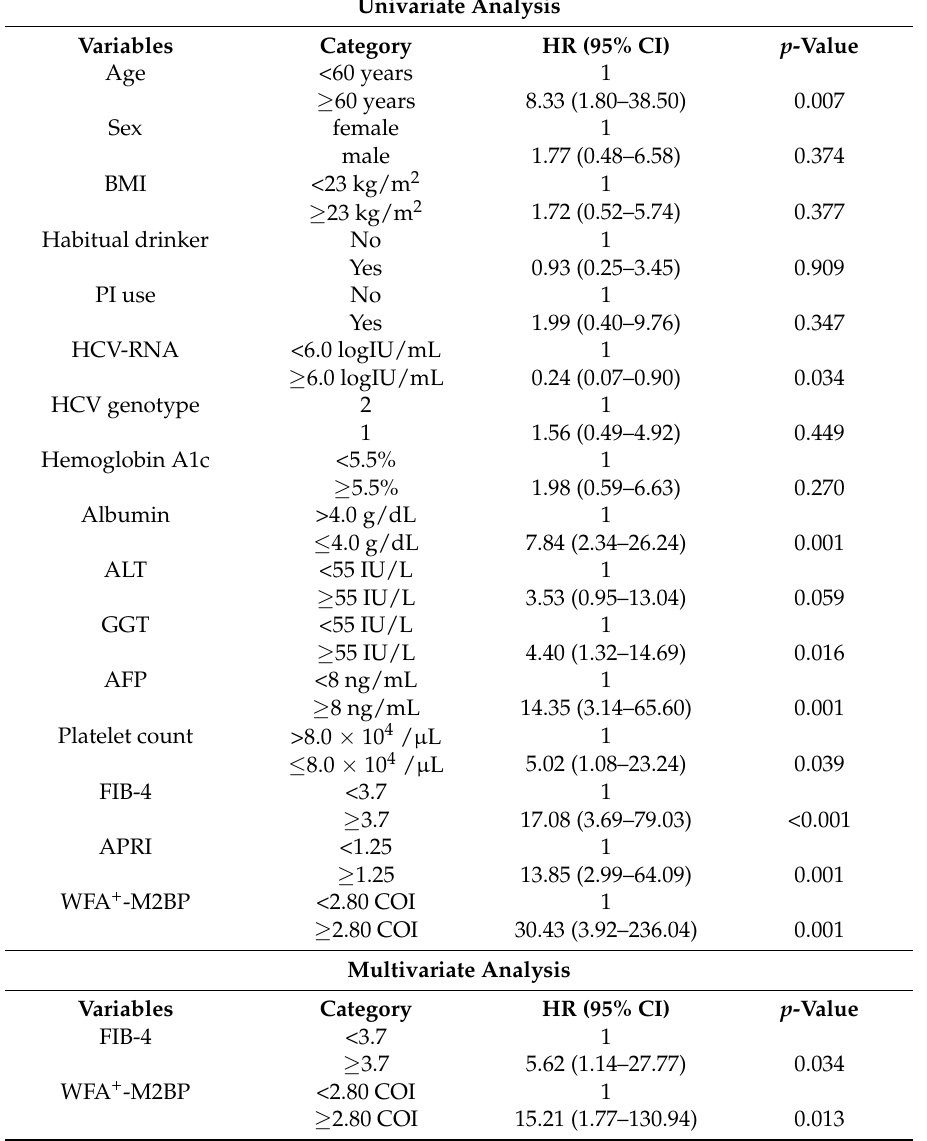
Table 2. Univariate and multivariate analyses of factors associated with hepatocellular carcinoma